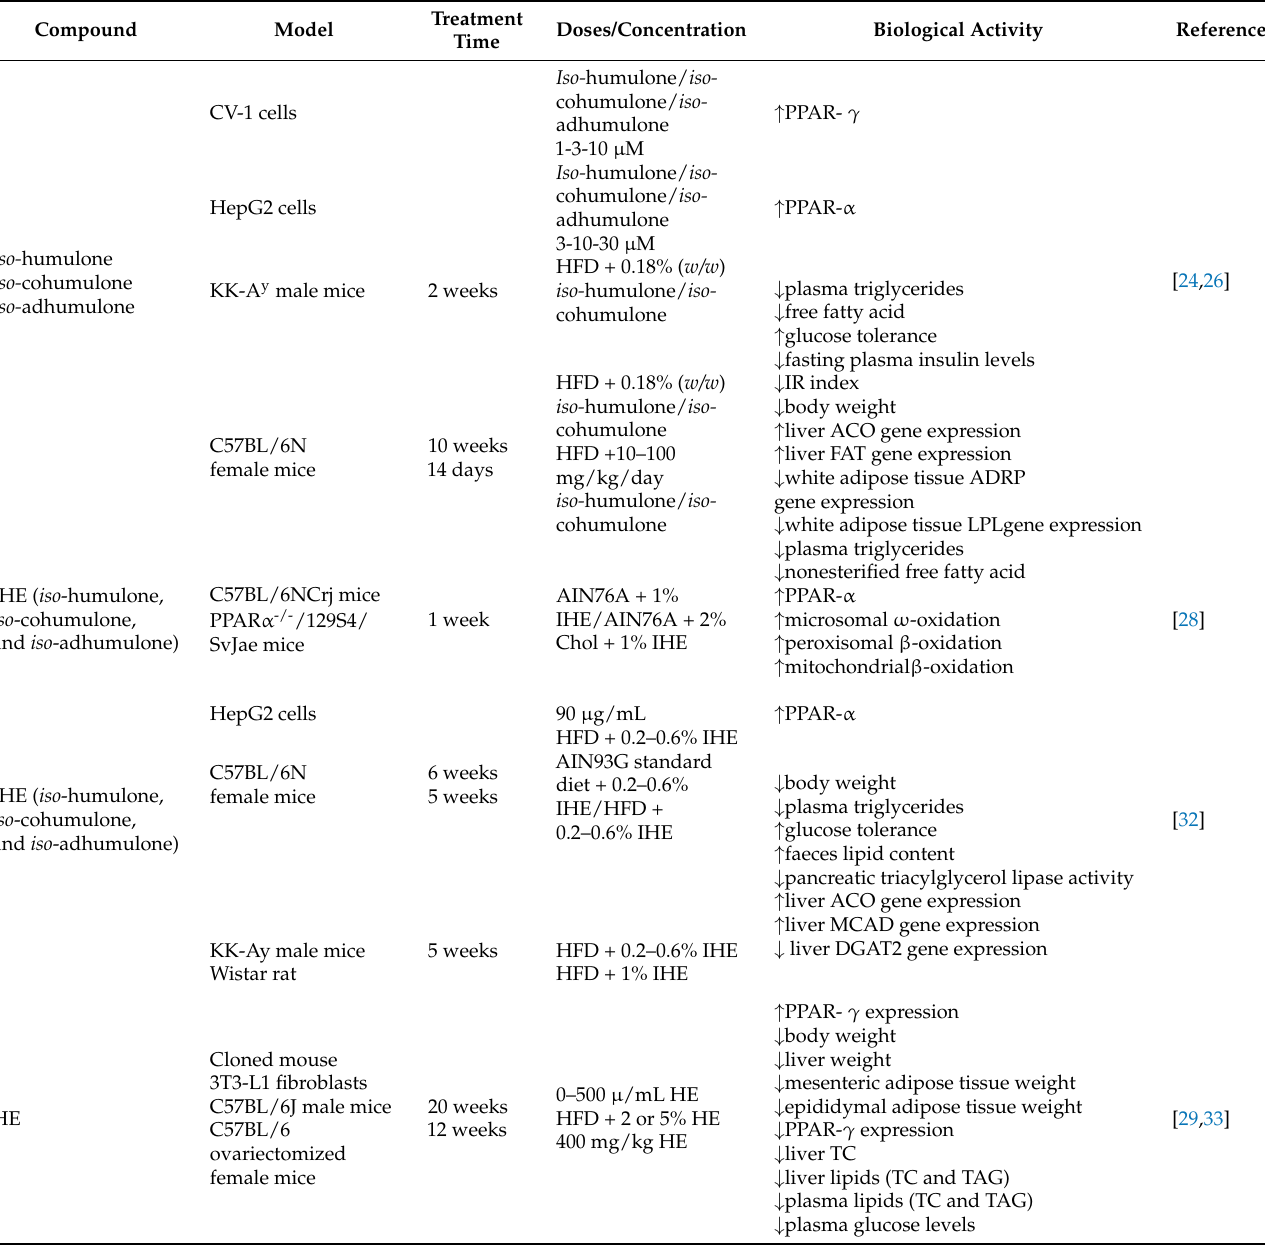
Table 2. Description of in vivo/in vitro mechanisms involved in the decreased incidence of metabolic disorders. Treatment Compound Model Doses/Concentration Biological Activity Time